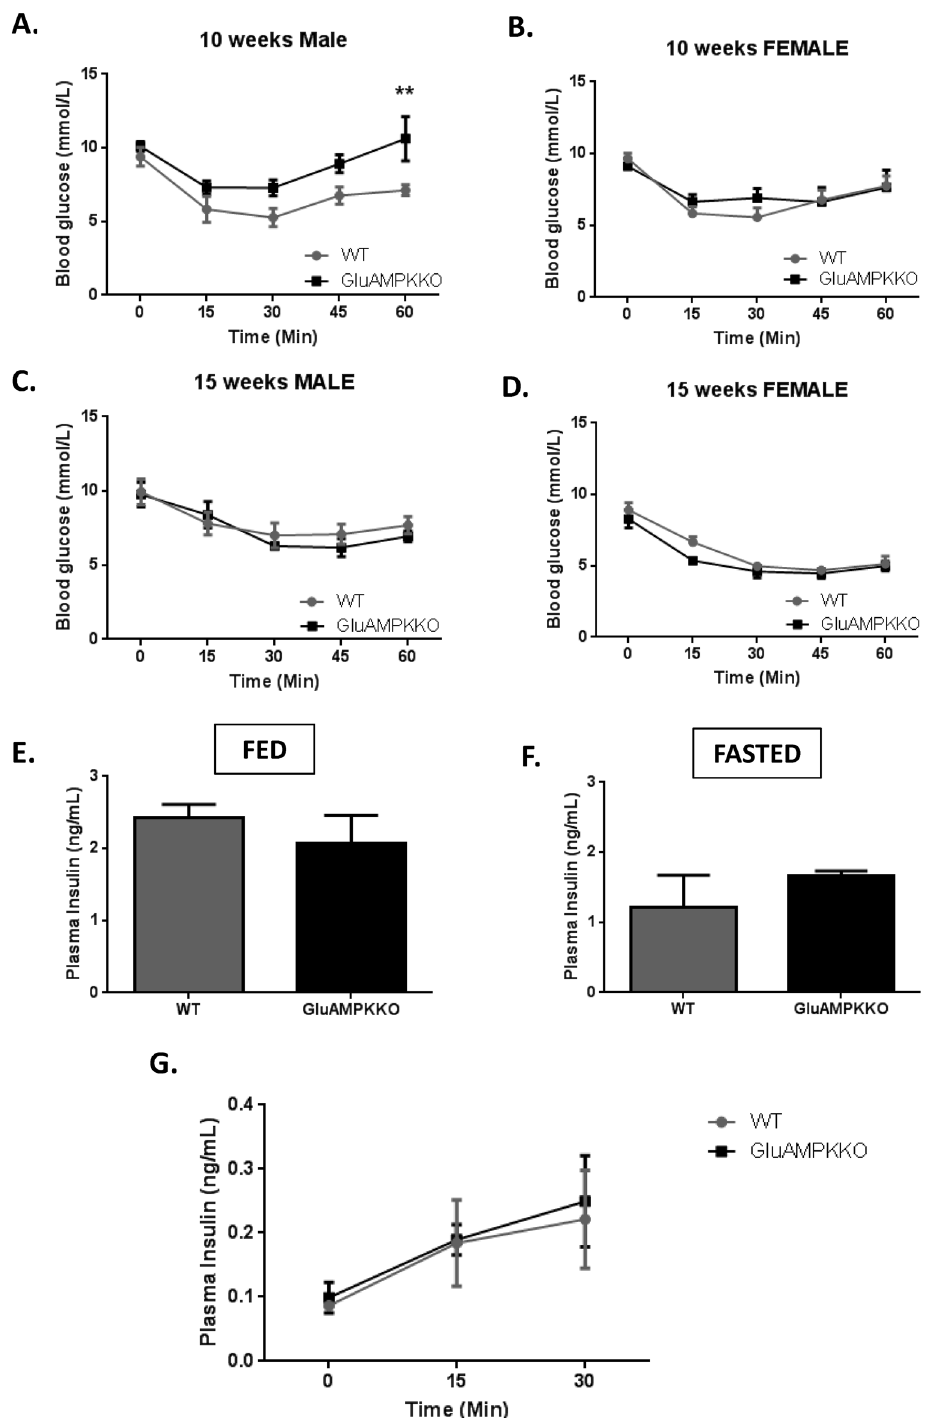
Fig 3. AMPK α 1 and - α 2 deletion has no or minor effects on glycaemia after insulin injection, or on circulating insulin levels. (A,B) Intraperitoneal insulin tolerance tests (ITTs) were performed on 10 week old male and female mice after mice after fasting for 5 h. Blood glucose levels were measured 0, 15, 30, 45 and 60 min. after insulin injection. (C,D) ITTs were repeated on 15 week old male and female mice, n = 5 – 9 mice/ sex/genotype. ** P < 0.01, by 2-way ANOVA. (E,F) Plasma insulin levels were measured in iGluAMPKdKO and WT mice when fed as normal or after being fasted overnight and (G) at 0, 15 and 30 min. after glucose injection. n = 3 mice/genotype, mixed male and female. Data expressed as means ±